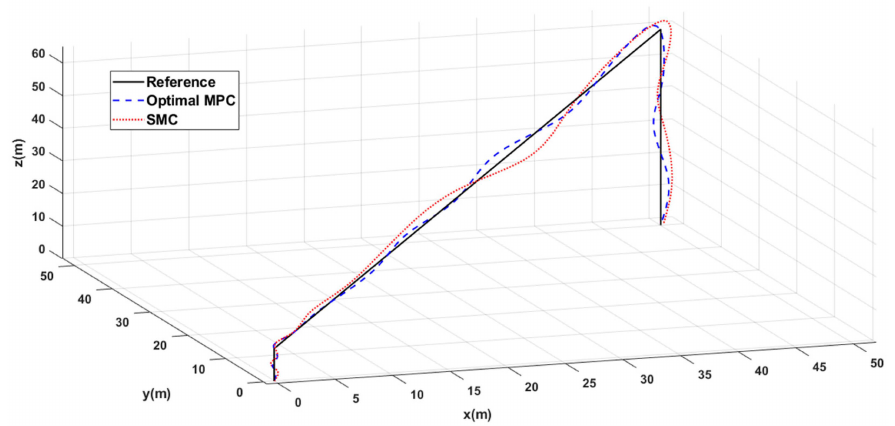
Figure 3. The result of applying the proposed control method and SMC method [50] to the helicopter in the third scenario.